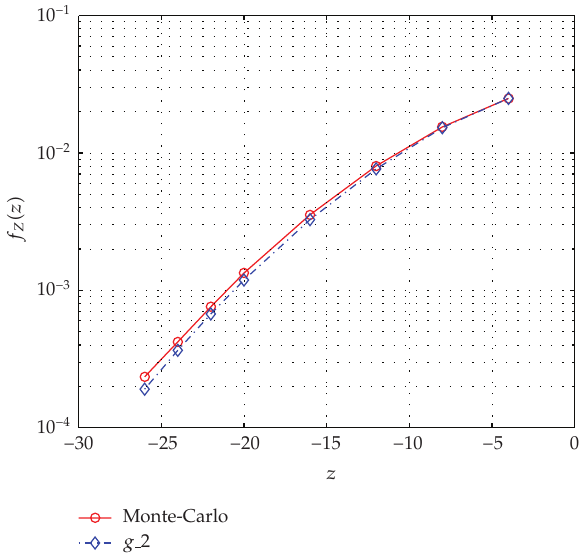
Figure 2: Left tail f Z ,ρ (cid:8) σ 1 /σ 2 . g 2 is the